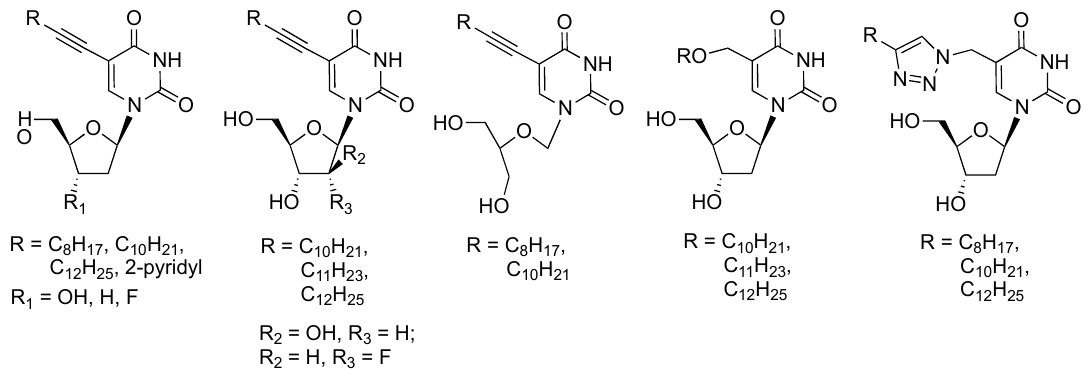
Figure 1. Previously reported anti- M. tuberculosis nucleosides.